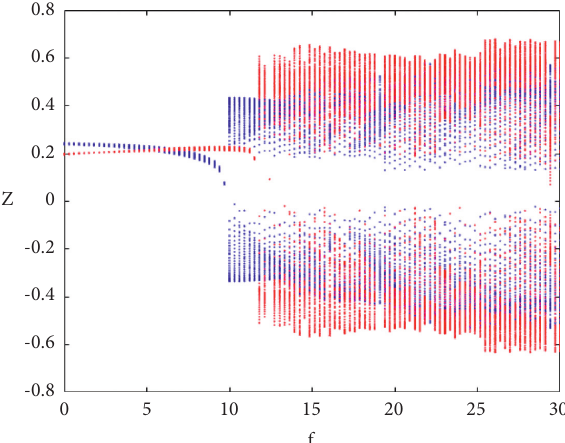
Figure 8: Coexisting bifurcation diagram of the state variable z with respect to the control parameter